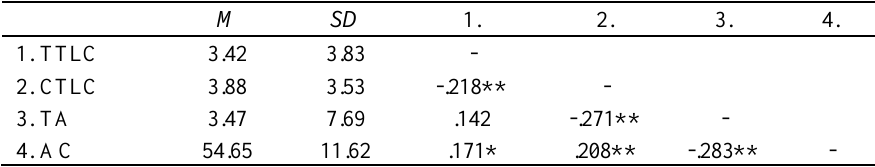
Correlations matrix amongst teaching-learning conceptions, test anxiety, and academic achievement